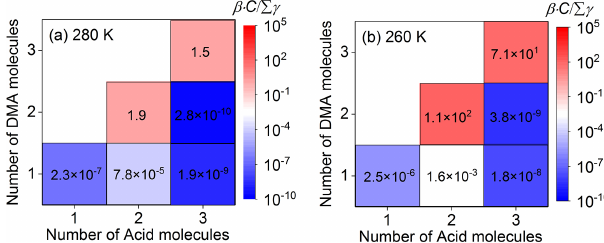
Figure 1. Ratios of SA monomer collision frequencies versus total evaporation frequencies ( β · C/(cid:54)γ ) for ( SA ) x · ( DMA ) y · ( TFA ) 1 (0 ≤ x ≤ 2, 1 ≤ y ≤ 3, y ≤ x + 1) clusters at different temperatures (280 and 260K). Acid molecules are SA and TFA. C = 1 . 0 × 10 6 molec.cm − 3